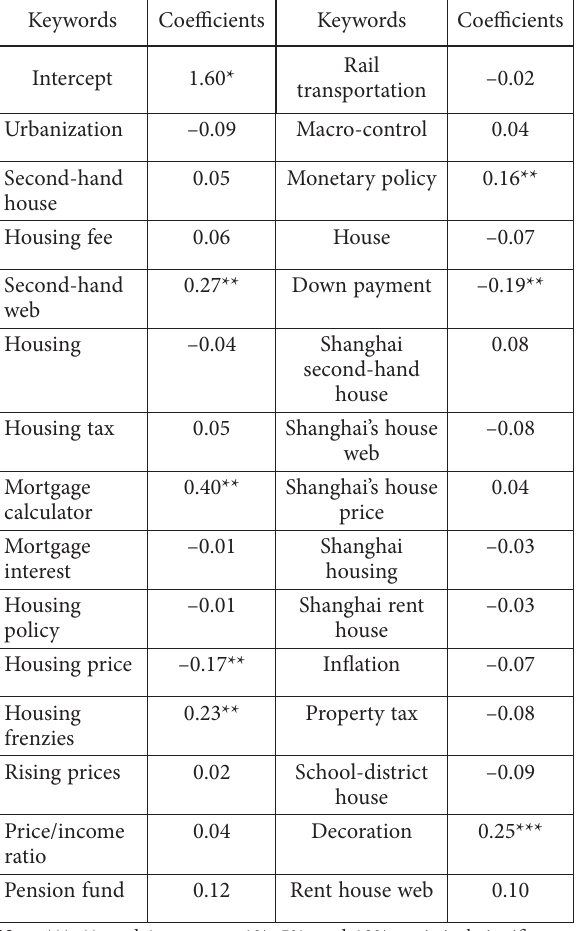
Table 3. Estimation results of main keywords based on generalized